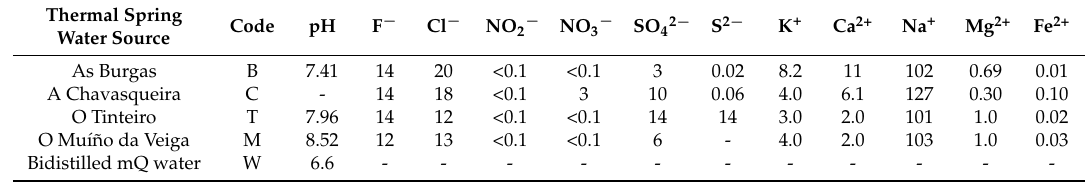
Table 1. pH values, anions (fluoride, chloride, nitrate, nitrite, and sulfate contents), and cations (K + ,